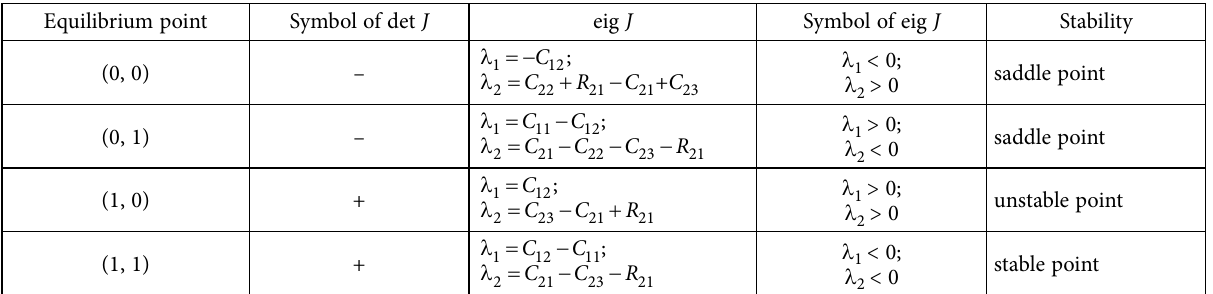
Table 2. The stability analysis of the evolutionary game based on Section 4.1 Equilibrium point Symbol of det J eig J Symbol of eig J